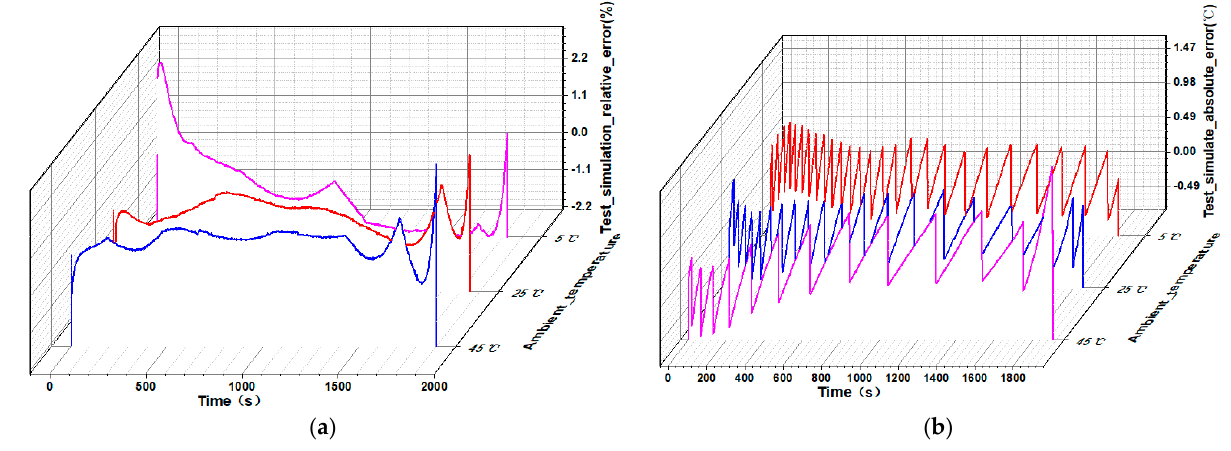
Figure 8. ( a ) Relative errors of output voltage between experimental and model at different ambient temperatures; ( b ) Absolute errors of average temperature between experimental and model at different ambient temperatures.